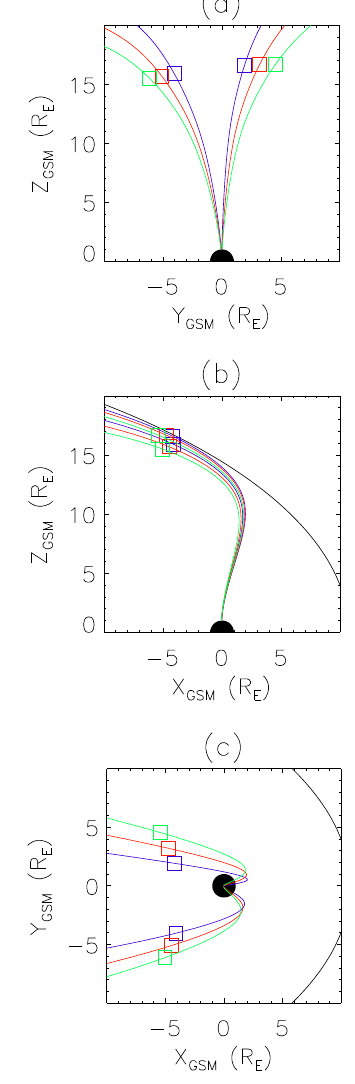
Fig. 11. The paths of magnetic field lines mapped from the ends of the estimated merging line location in the ionosphere to the lobe magnetopause, using the Tsyganenko 96 magnetospheric magnetic field model. Panels ( a ) , ( b ) , and ( c ) represent the projections into the y – z , x – z , and x – y GSM planes, respectively. The three coloured field lines represent mappings for the three assumptions regarding the X-line length (see text for details). The square symbols repre- sent the best estimates of the ends of the in-situ X-line (see text for